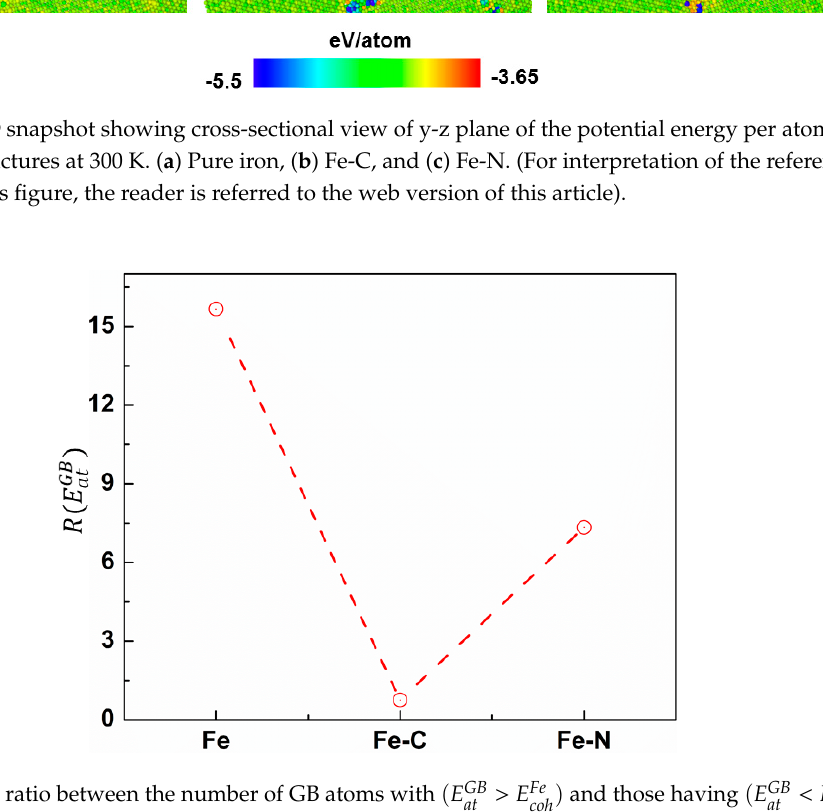
Figure 3. The ratio between the number of GB atoms with ( E GB corresponding to different nc samples.